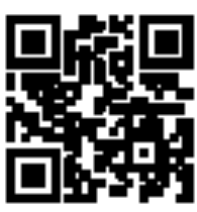
Figure 2. Watermark of 64 × 64 bits.